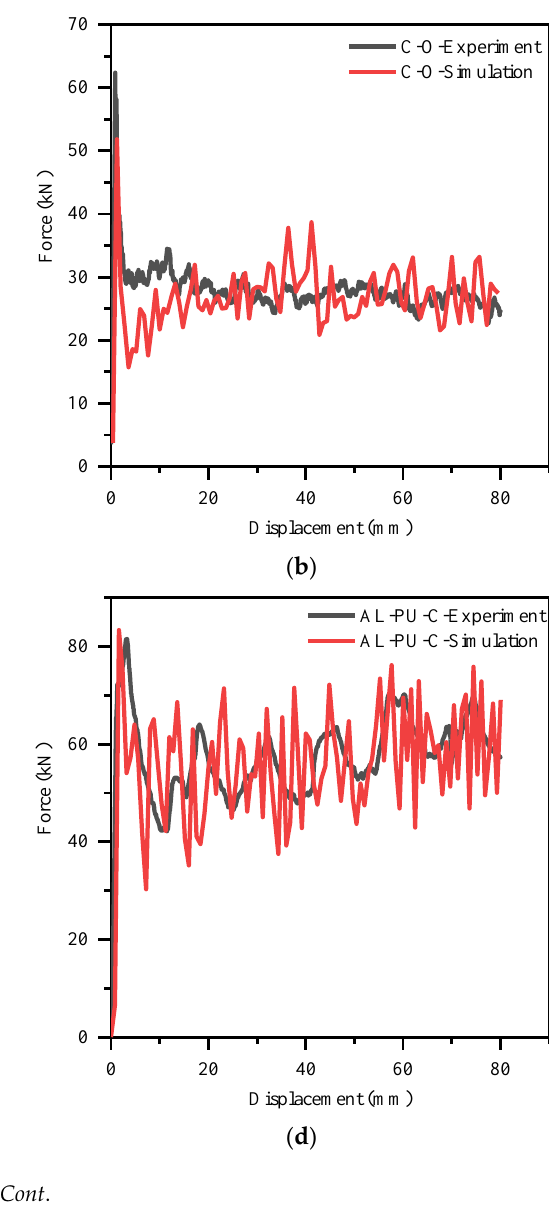
Figure 9. Comparison of deformation mode between the experimental results and simulation results: ( a ) AL-O; ( b ) C-O; ( c ) AL-PU-AL; ( d ) AL-PU-C; ( e ) C-PU-AL; ( f ) C-PU-C.